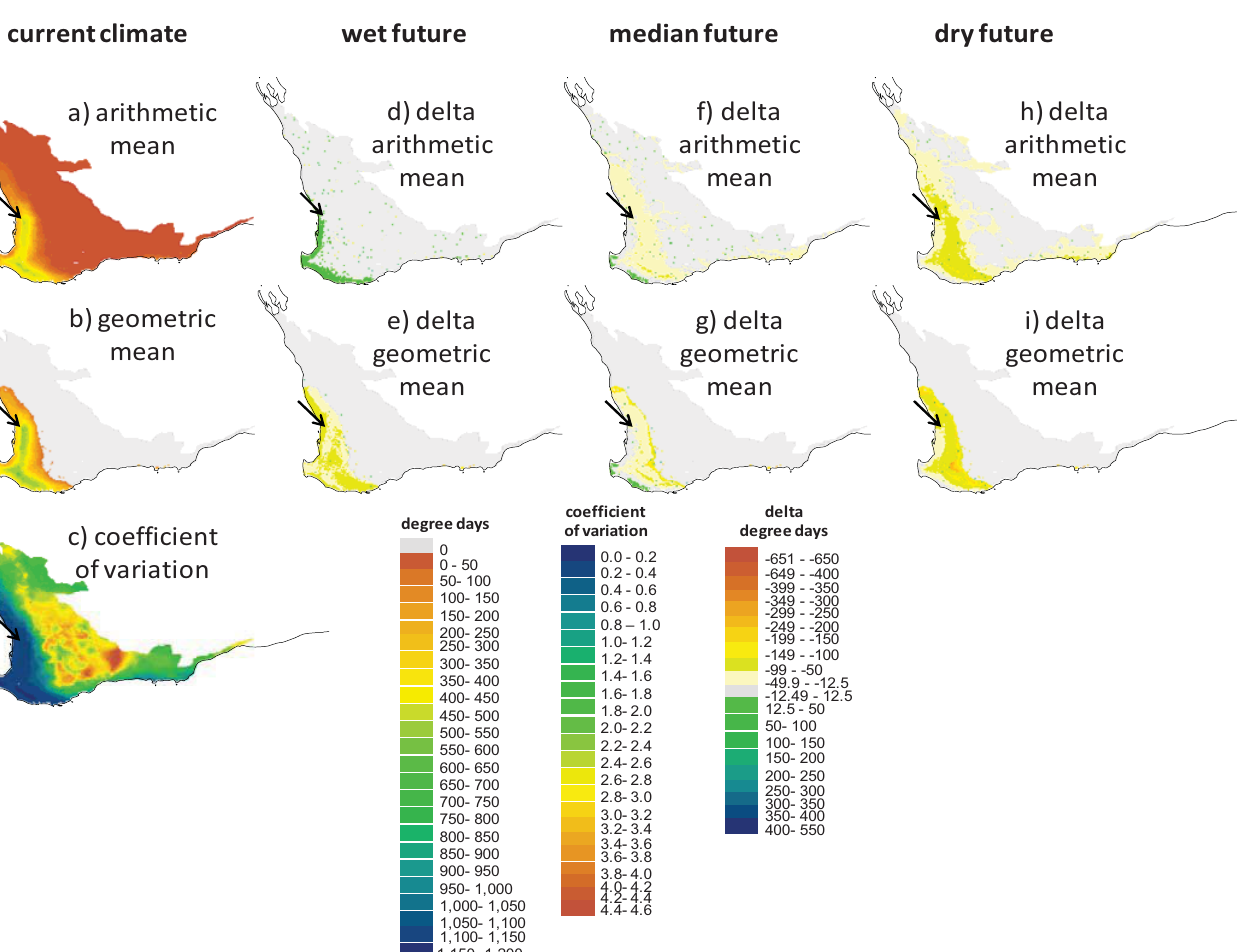
Figure 6. Screening maps of the output of NicheMapR coupled with WET-R showing ( a ), the arithmetic mean, ( b ) the geometric mean and ( c ) the coefficient of variation of the degree days above 14 °C, assuming the tortoises will attempt to raise body temperature by basking during the hydroperiod if water temperature was unsuitable for foraging (<14